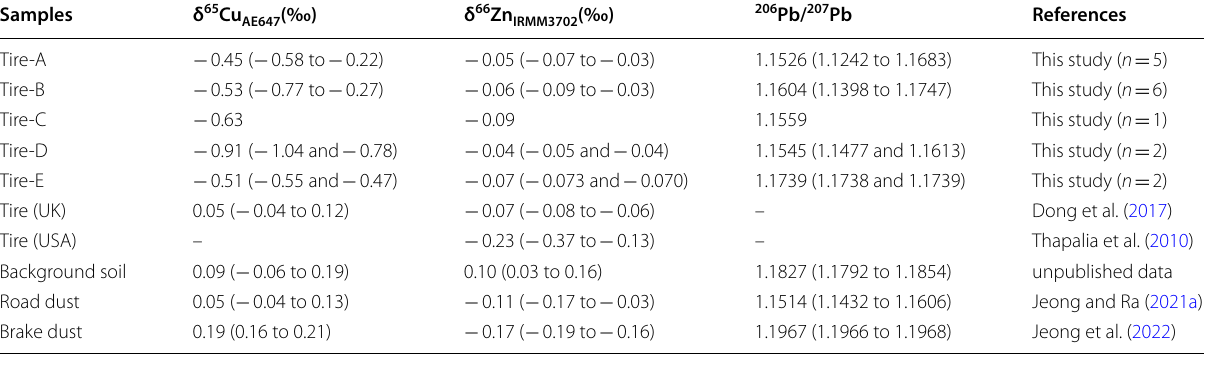
Table 2 Comparisons of the mean, minimum, and maximum values of the Cu, Zn, and Pb isotopic compositions in this study with results in the literature